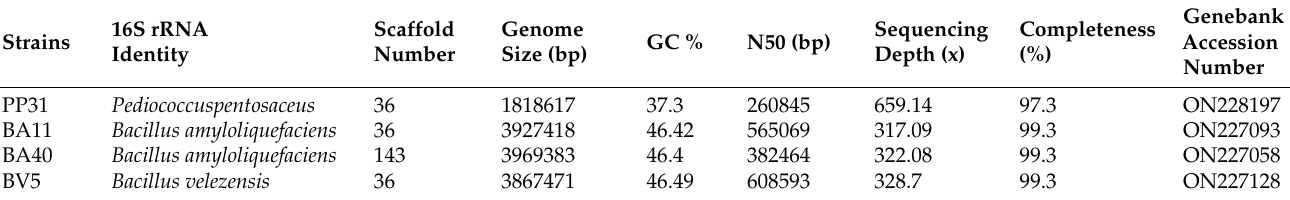
Table 2. Genomic features of isolated strains.